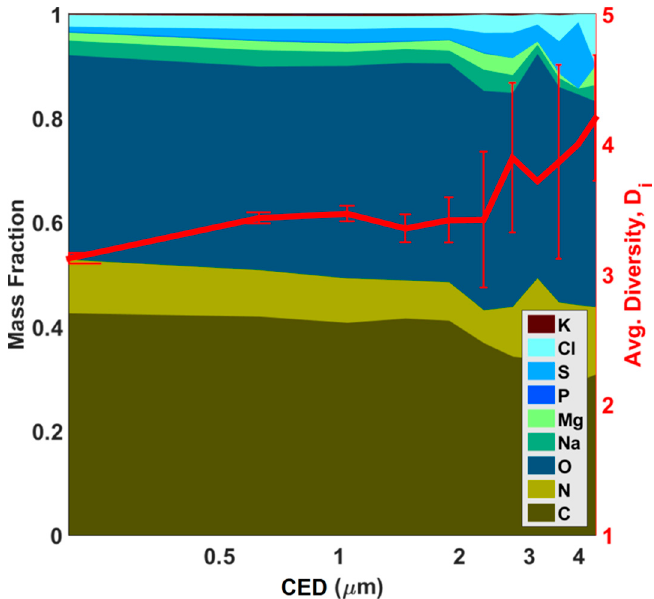
Figure 7. Elemental composition (mass fraction) and average individual particle diversity D i (red trace) as a function of Circular Equivalent Diameter (CED) for all particles analyzed across all samples. Of note is that only 32 particles with diameters >2 µm were analyzed which is why this region is fairly noisy. Error bars are not shown when only a single particle of that size was measured. Only 9 elements are labeled (with P and K seen as small slivers) whereas the others are too small to be seen in the figure.